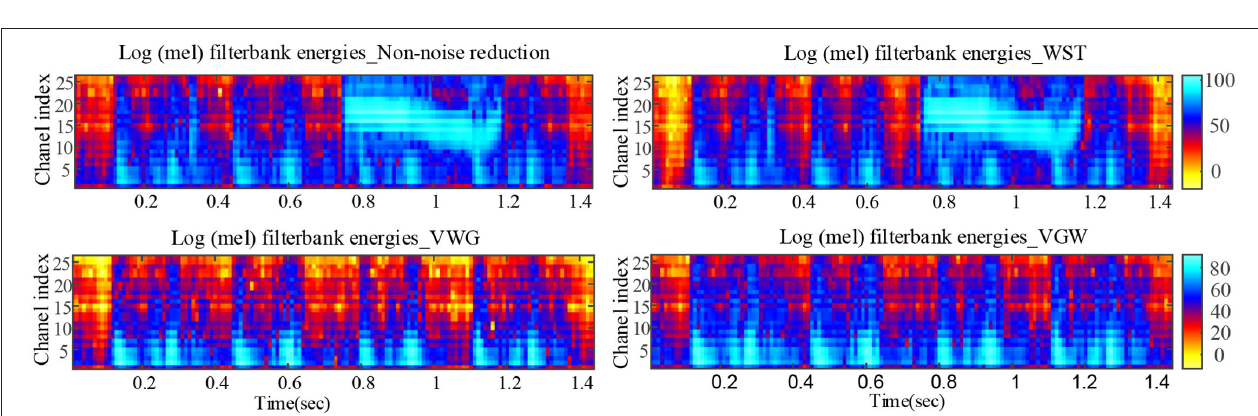
FIGURE 5 | PCG without crying noise (top), PCG with severe crying noise and noise reductions for the PCG with severe crying noise.